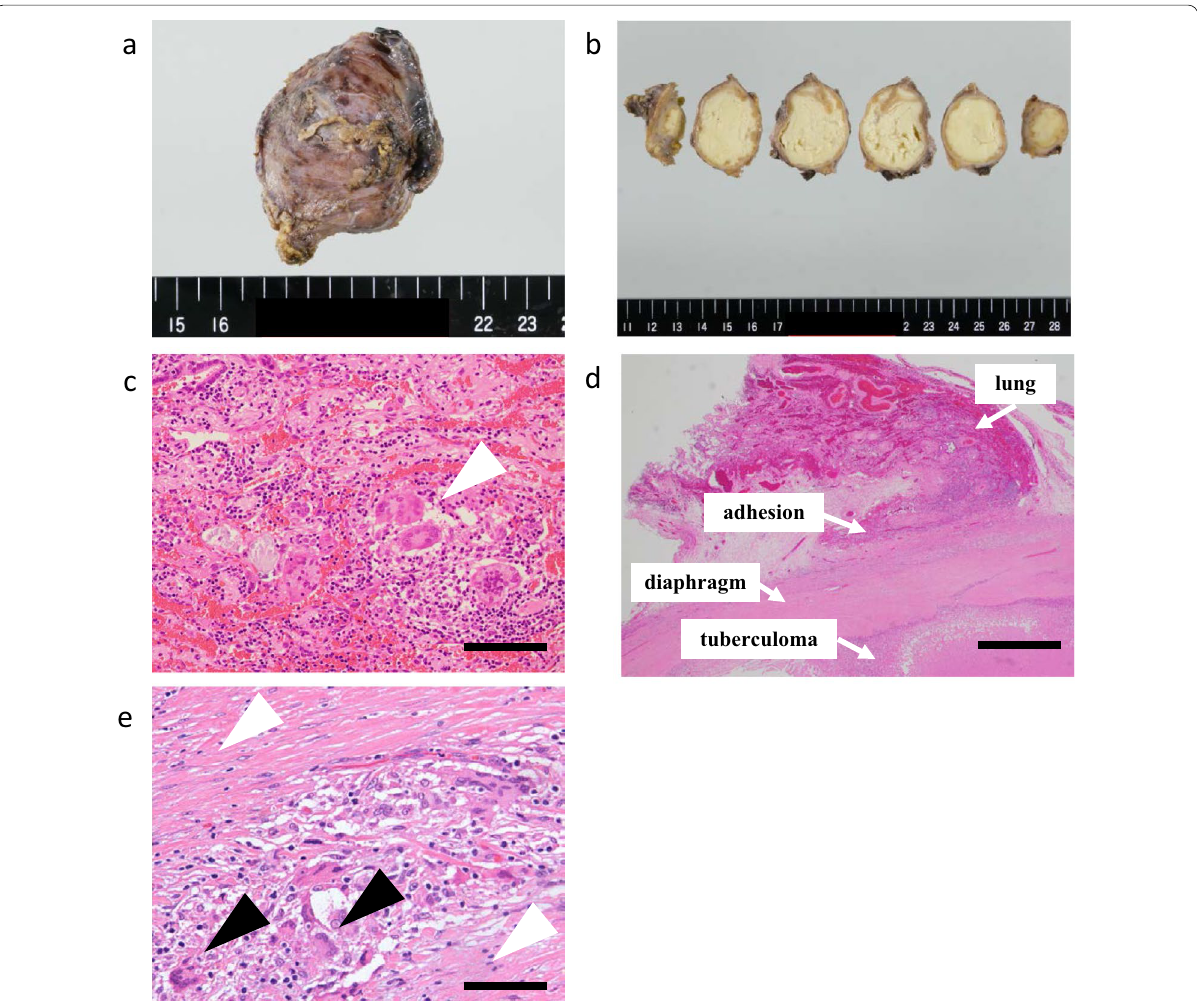
Fig. 3 Macroscopic findings and histopathological findings. a , b Mass in the left diaphragm was 68 mm in size, and the cut surface showed yellow content covered with a thick wall. c Conventional hematoxylin- and eosin-stained section of lung tissue adhered to the tuberculoma showed epithelioid cell granulomas composed of histiocytes and multinucleated giant cells (white arrow heads). Bar: 100 µm. d Adhesion was present between the tuberculoma and left lower lung. Bar: 1 mm. e Histiocytes and multinucleated giant cells (black arrow heads) were found in the diaphragmatic muscular layer (white arrow heads). Bar: 50